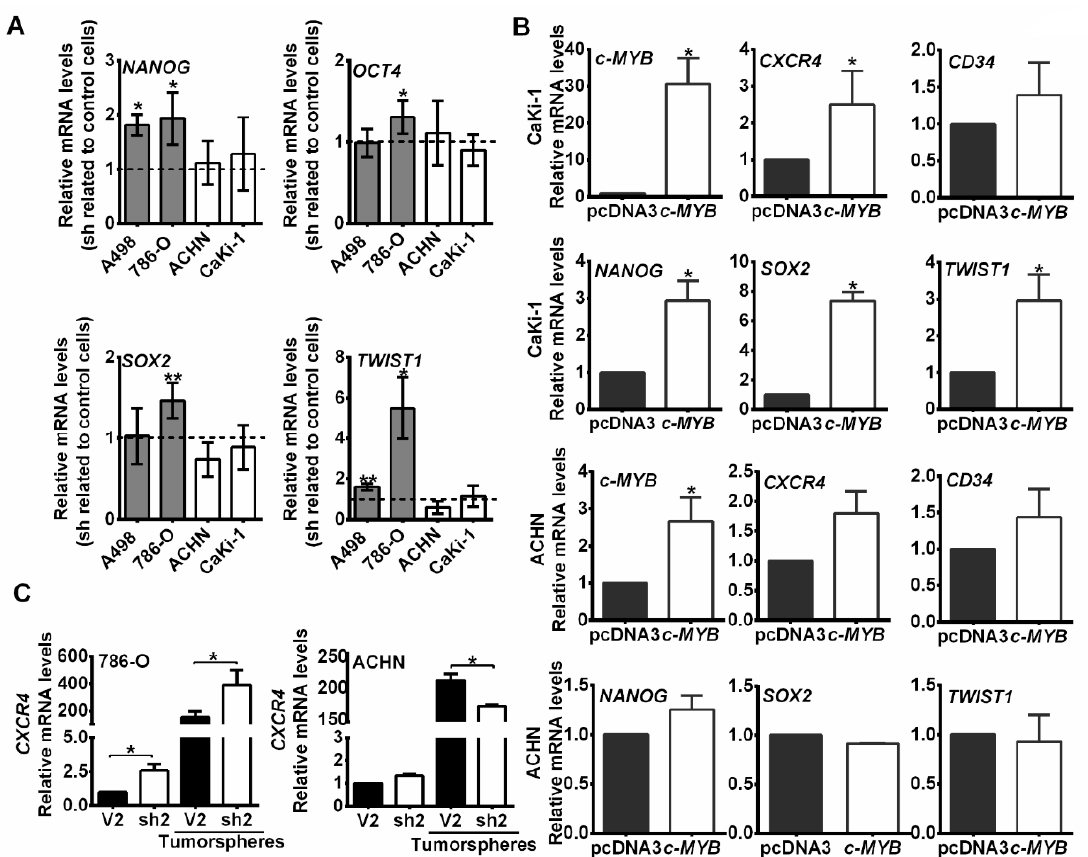
Figure 4. MYBBP1A knock down in c-MYB + cell lines induces the expression of stem genes. ( A ) Measurement of NANOG, OCT4, SOX2 and TWIST1 expression by Q-RT-PCR. Graphs represent mRNA levels in MYBBP1A knock down cells normalized to the mRNA levels of control cells. ( B ) CaKi-1 and ACHN cell lines were transfected with c-MYB cDNA and the empty vector (pcDNA3). After selection, c-MYB, CXCR4, CD34, NANOG, SOX2 and TWIST1 expression were measured by Q-RT-PCR. Graphs represent mRNA levels in cells expressing c-MYB cDNA normalized to the mRNA levels of control cells. ( C ) CXCR4 mRNA levels from adherent cells and tumorspheres were measured by Q-RT-PCR. Graphs represent mRNA levels of 786-O and ACHN cells expressing sh2 normalized to mRNA levels of control cells (V2). ( A – C ) Graphs show the mean ± SD of three independent experiments performed in triplicate. * p < 0.05; ** p < 0.01. To compare whether the effect of c-MYB overexpression in c-MYB negative cells was similar to MYBBP1A knock down in c-MYB positive cells, we overexpressed MYB cDNA in the c-MYB negative